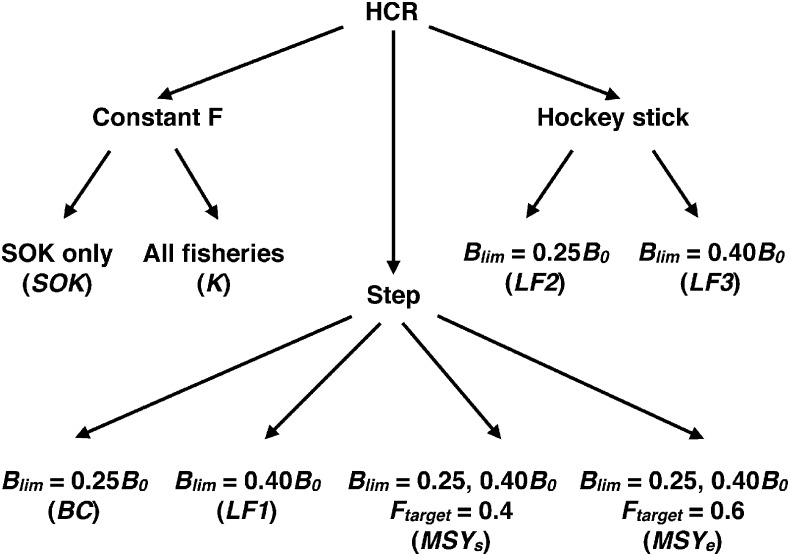
The management strategy evaluation scenarios classified by harvest-control-rule type, Ftarget and Blim.